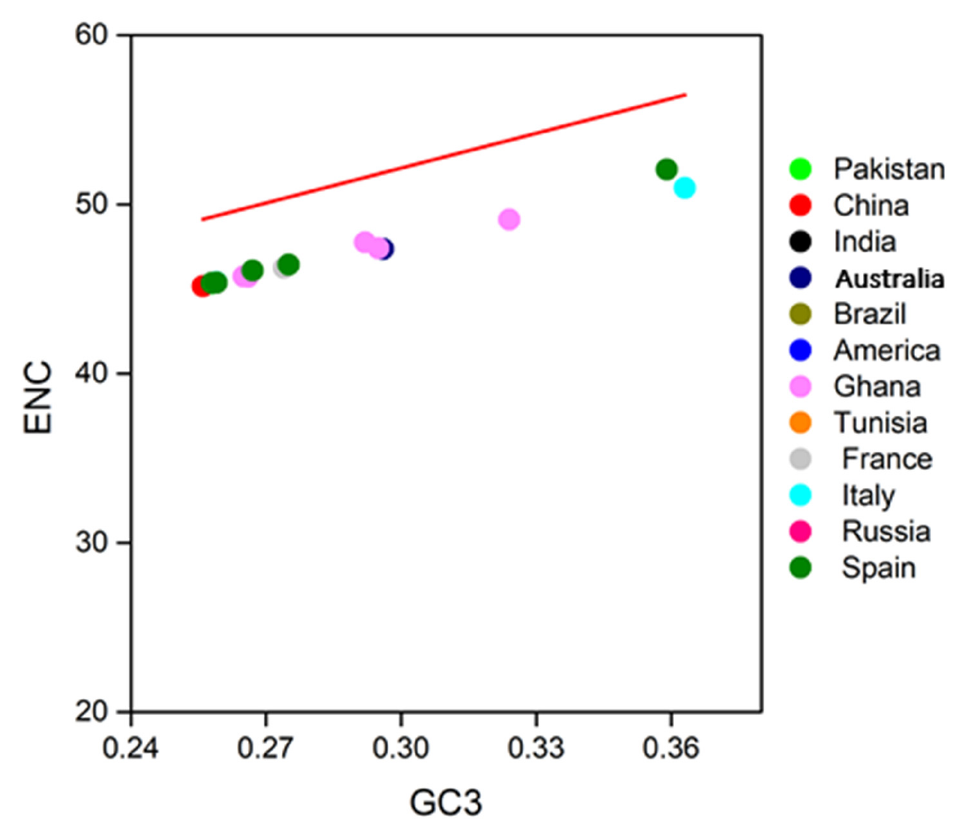
Figure 3. ENC versus GC3 plots of 60 SARS-CoV-2 isolates are represented in different color schemes.